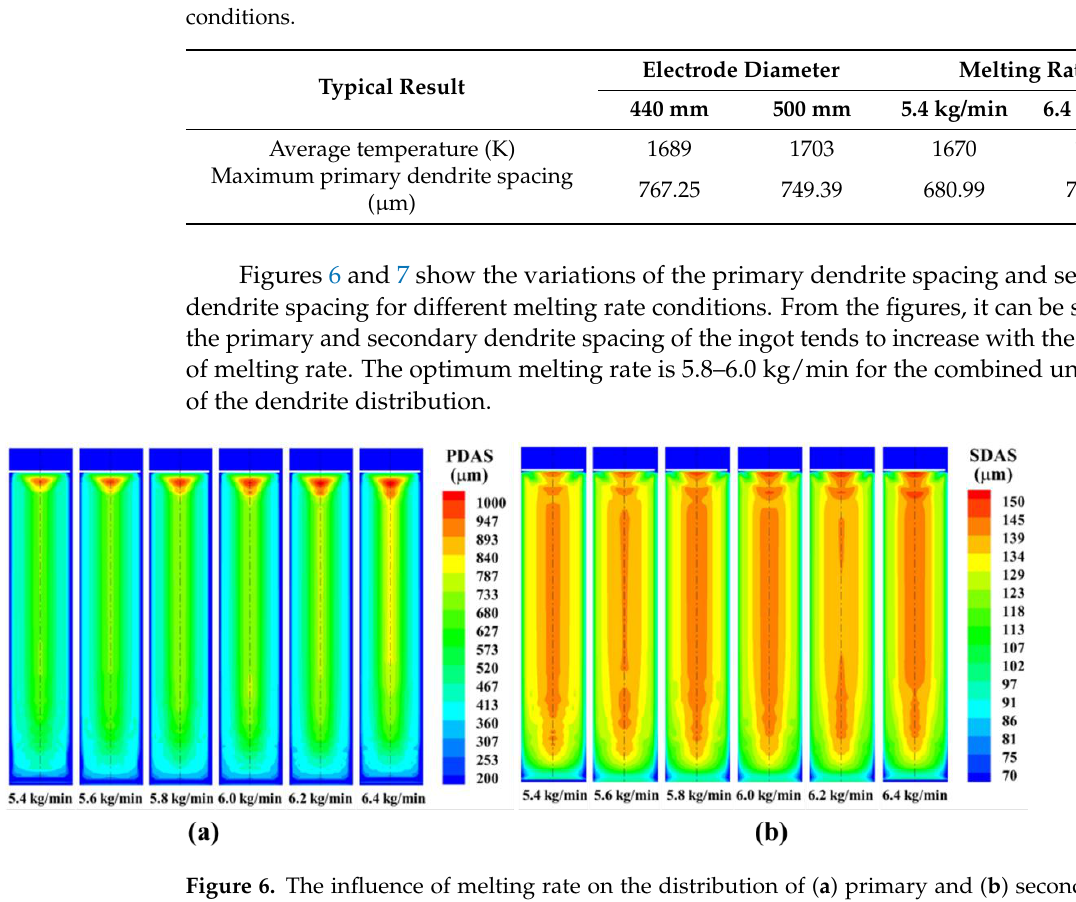
Figure 6. The influence of melting rate on the distribution of ( a ) primary and ( b ) secondary dendrite spacing.